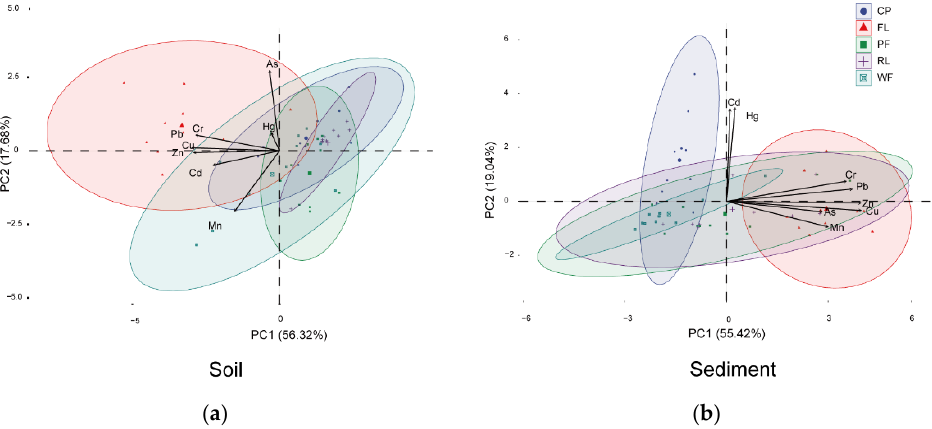
Figure 7. Results of principle component analysis of metal concentrations in the surface soil ( a ) and sediment ( b ) samples.